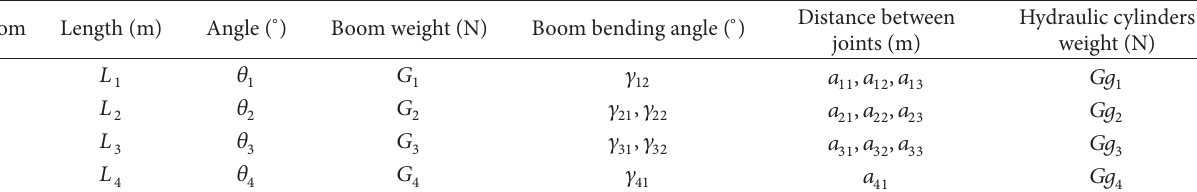
Figure 1: Multibody manipulator structure model and joint distance. Table 1: Multibody manipulator parameters.